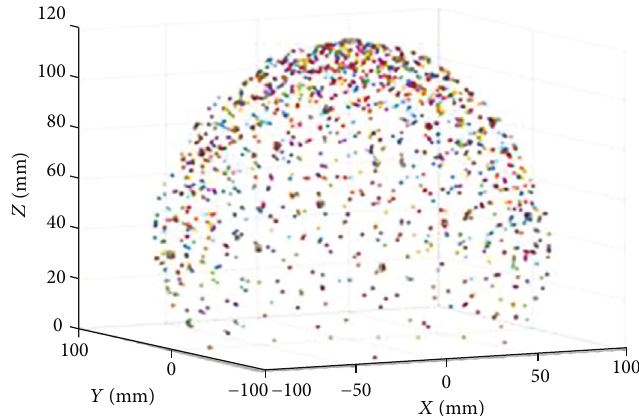
Figure 10: Two-segment catheter workspace in 3D.